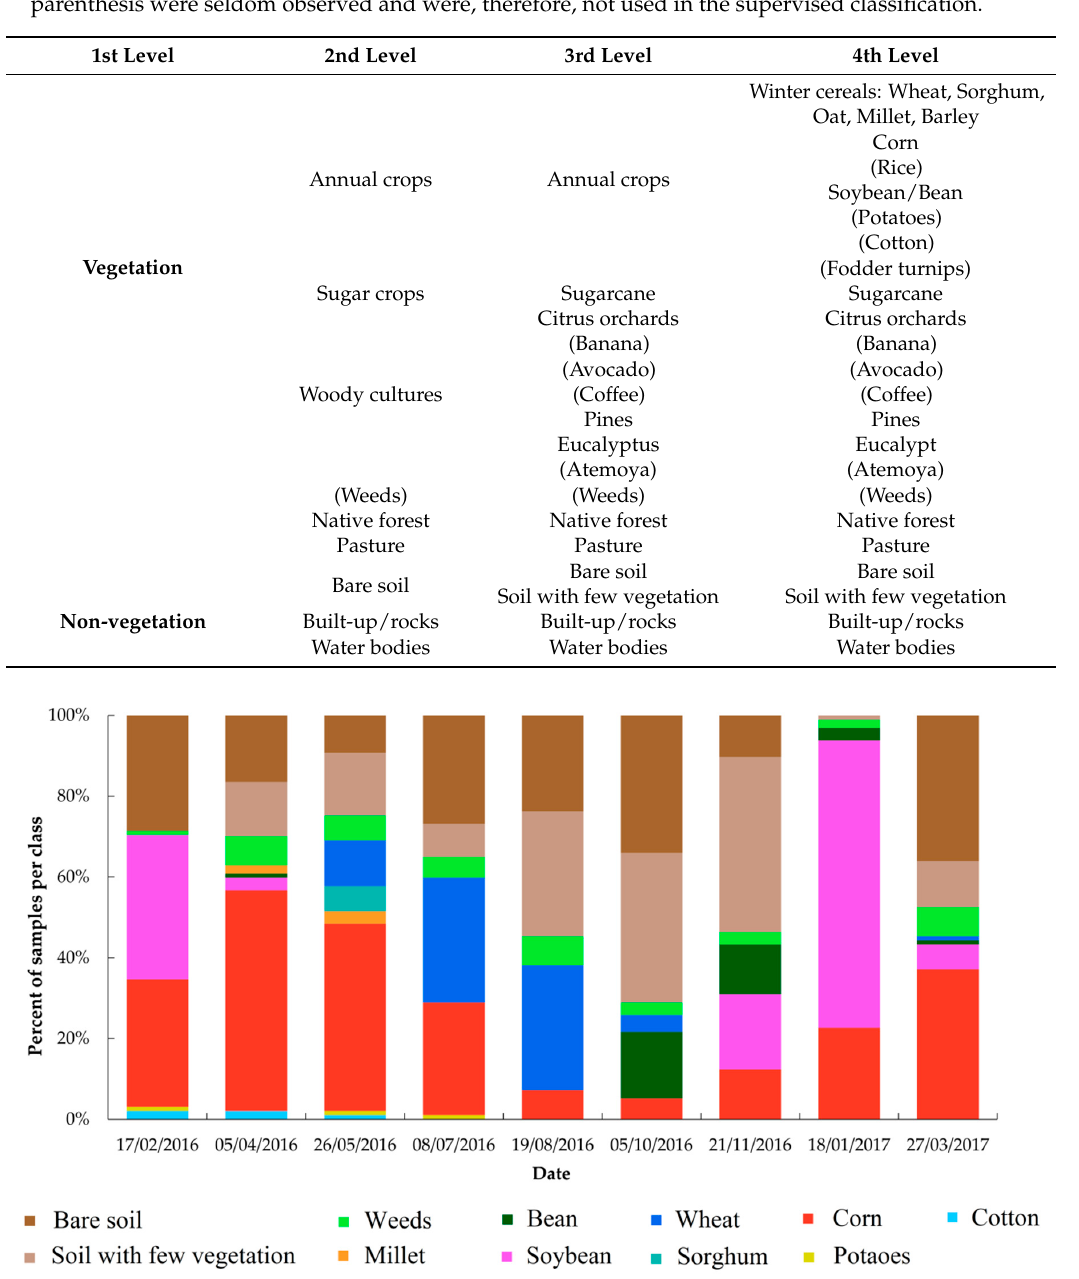
Figure 2. Percentage of samples per annual crop classes in the 97 crop fields, as measured every ~2 months. ~2